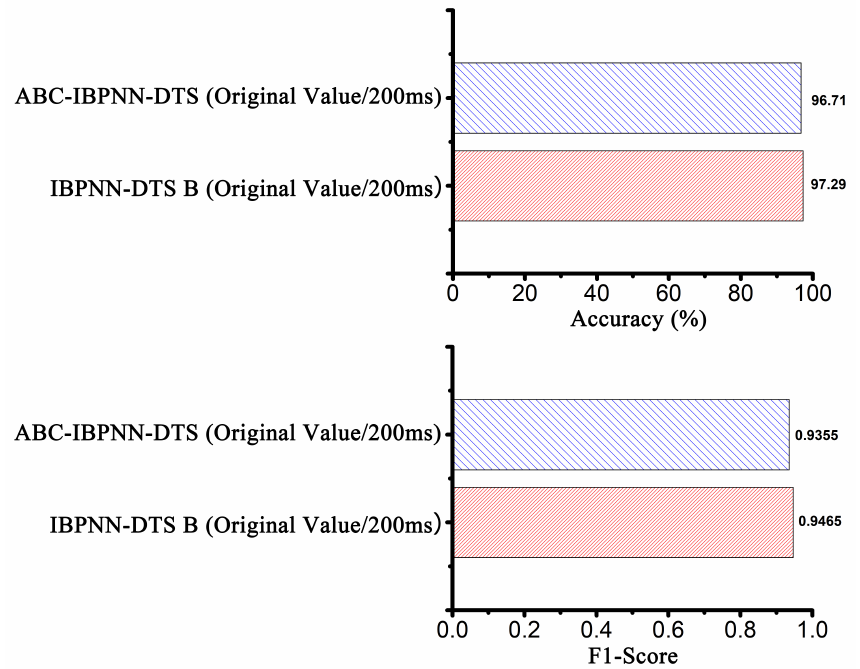
Figure 11. The evaluation index of IBPNN-DTS B models before and after optimization.